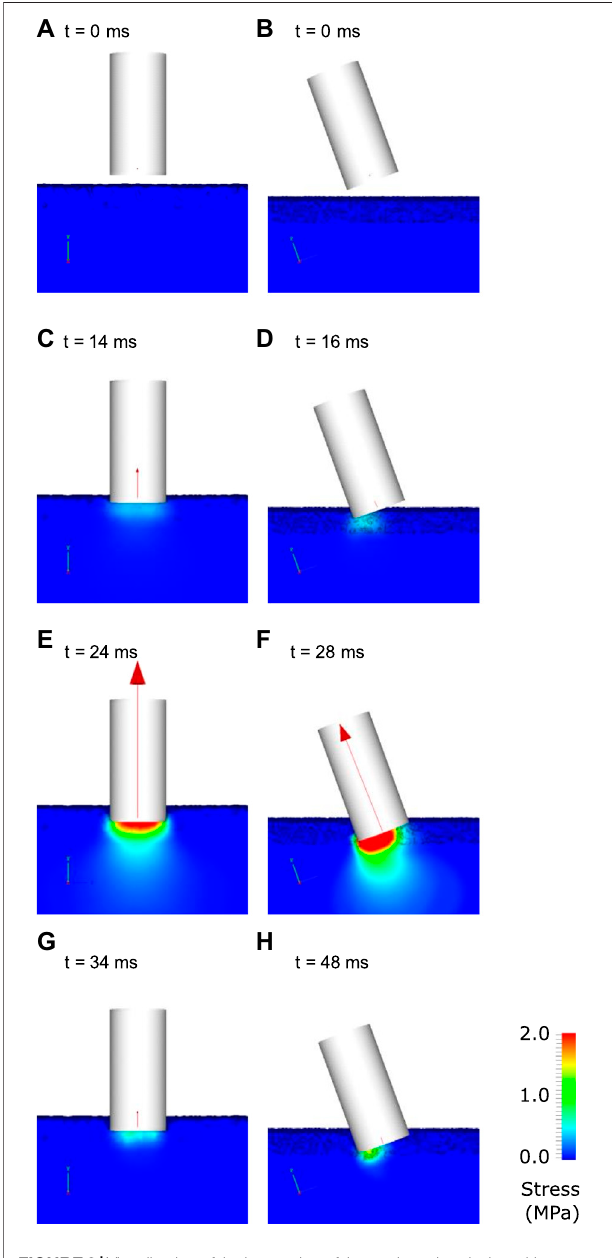
FIGURE8| Visualisationoftheinteractionofthetracktestingdevicewith ground for the case a synthetic track. The left columns show the results for a vertical impact and the right column shows results for an angled impact. The trackiscoloured byvonMises stress atvarioustimes indicated bylabels (A – H) . The net force on the TTD is shown as a red